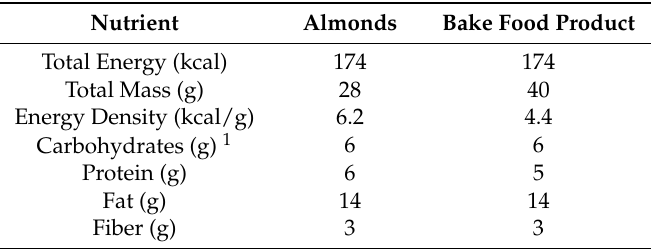
Table 1. Nutrient comparison of almonds and baked food product.